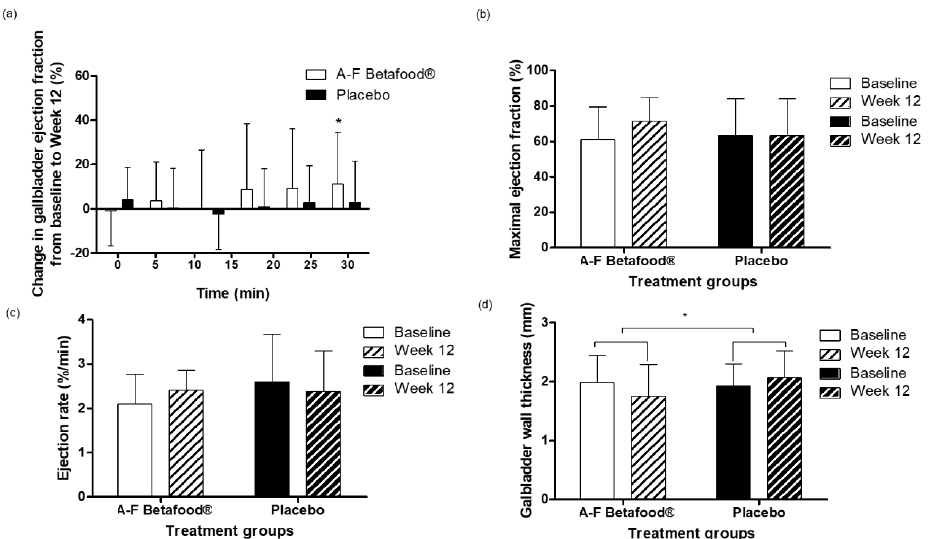
Figure 4. Gallbladder function in the per protocol population at baseline and week 12 post-supplementation with A-F Betafood ® or placebo (n = 42). ( a ) Mean change in ejection fraction, ( b ) mean maximal ejection fraction, ( c ) mean ejection rate, and ( d ) mean gallbladder wall thickness. Mean ± SD, where * p < 0.05. mm, millimeter.